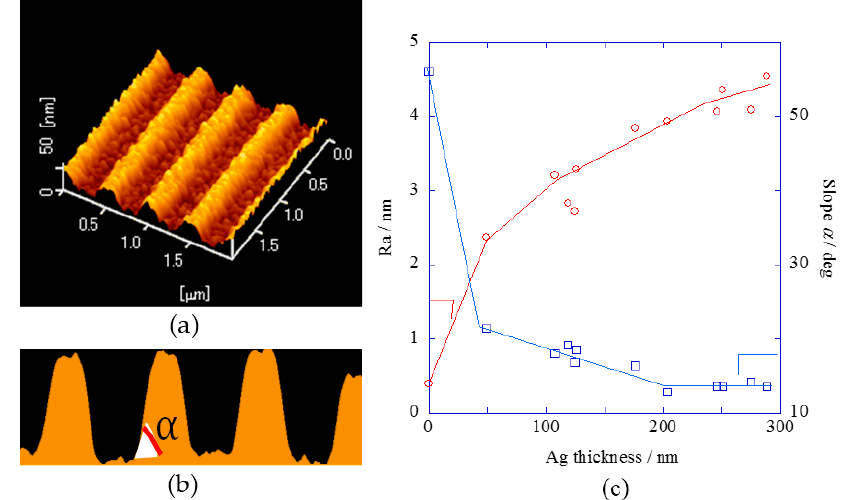
Figure 1. ( a ) Atomic force microscopy (AFM) image; ( b ) Cross-section contour of AFM image shows slope, α ; and ( c ) Ra and slope α plotted against the silver film thickness.